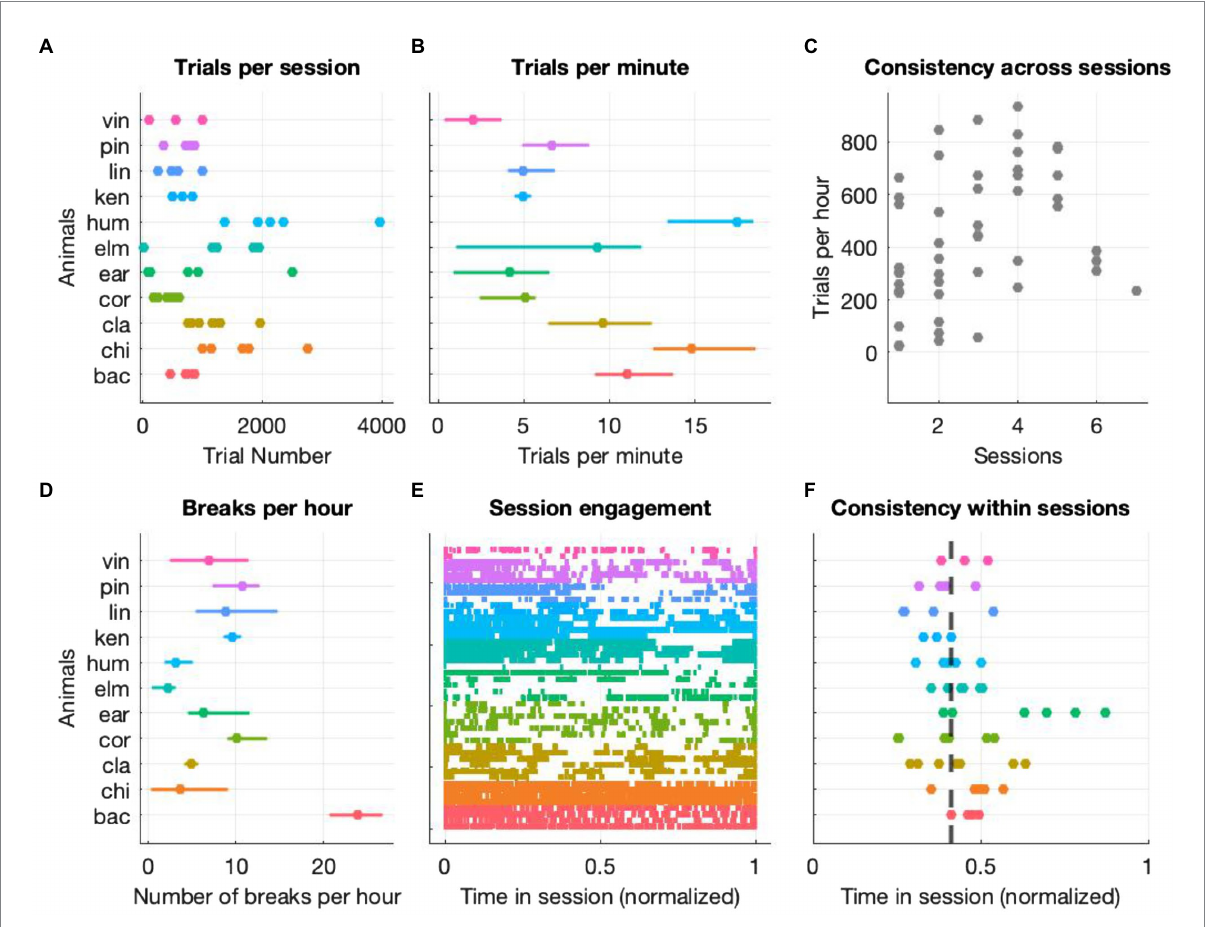
FIGURE 2 General level of engagement (monkeys only). (A) Number of trials performed by each animal with each data point representing one testing session (B) median number of trials per minute with variation across sessions expressed as interquartile range (C) average trials per hour for each session (across all animals) as function of consecutive sessions (D) median number of breaks per hour with variation across sessions expressed as interquartile range (E) event plot of all trials with each color representing one animal and each row representing a single session. Time is normalized to the session end. (F) Each dot represents the median trial time (normalized to the session end) of each session and animal. For each trial of each session, we first normalized all timestamps of each trial start to the session duration and then computed the median of the resulting distribution. Finally, we computed the median of all the medians and found that across all animals and sessions the median time point at which half of the trials were performed was 0.41 of the session’s duration, the dashed line on the